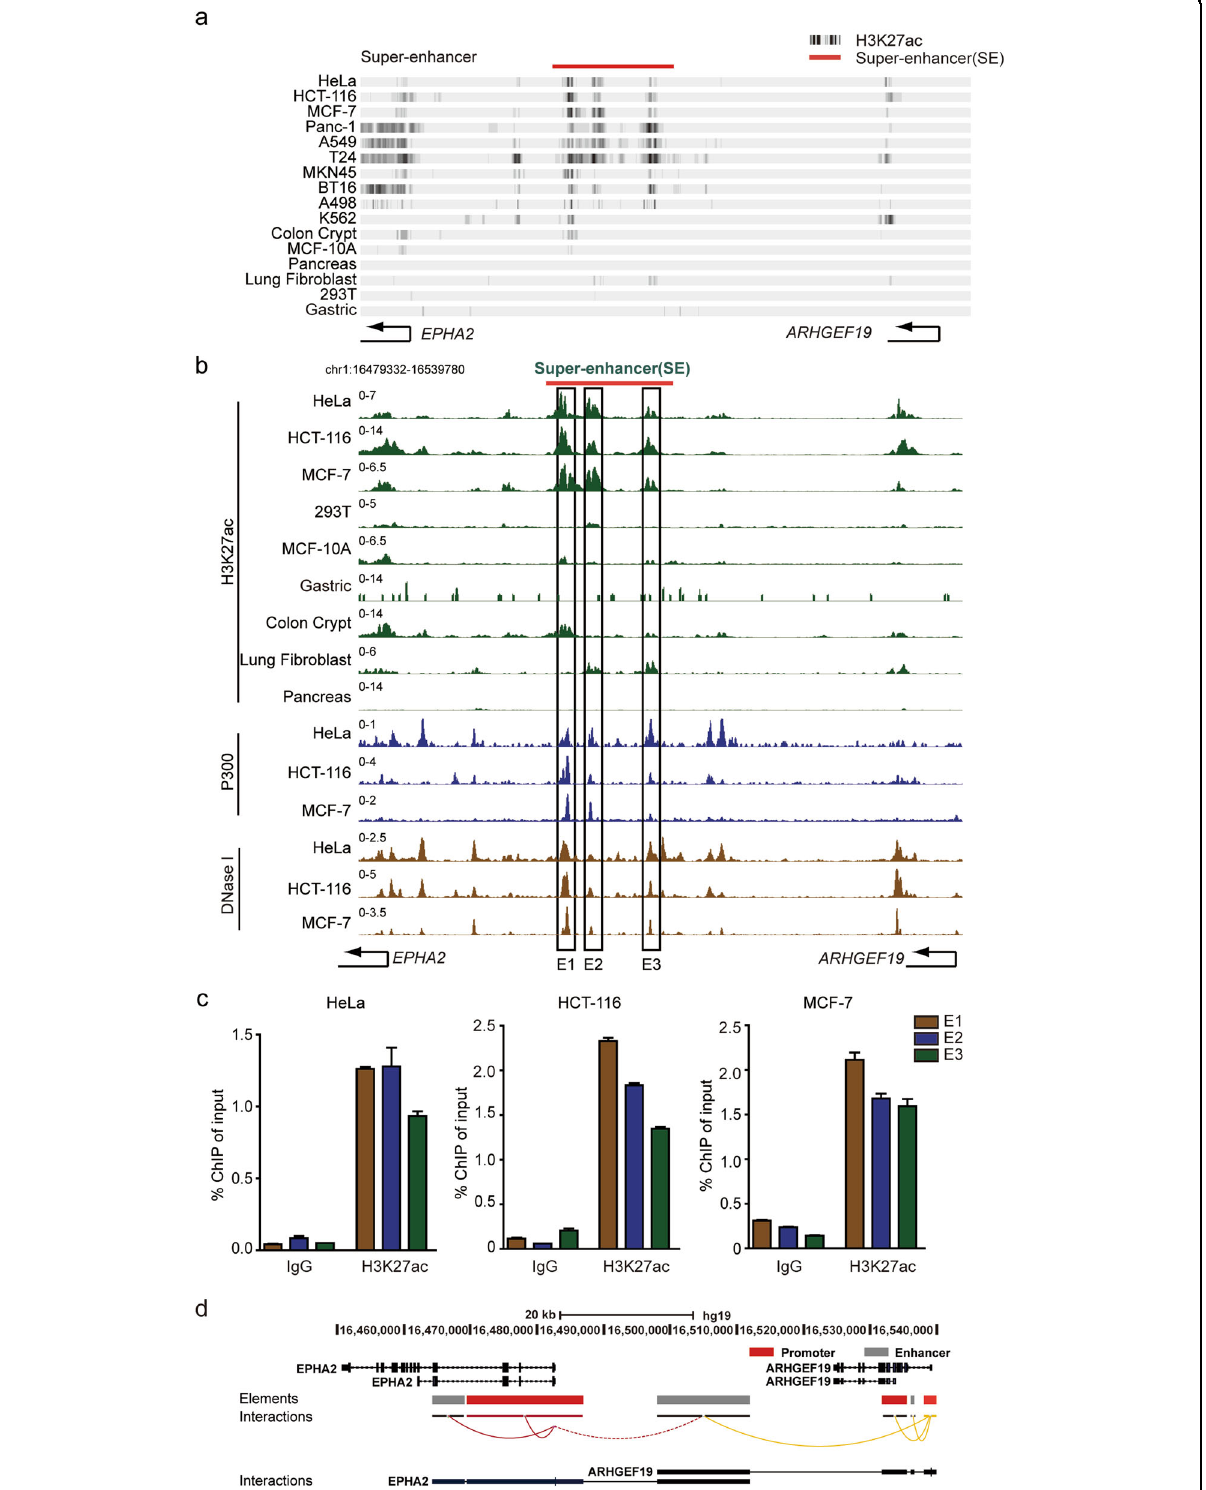
Fig. 1 Identi fi cation of a super-enhancer in ten tumor cells. a ChIP-seq binding pro fi les for H3K27ac enrichment were used to identify the super- enhancer in a variety of cancer cells. b The constituent enhancers of the super-enhancer (E1-E3) were identi fi ed based on markers of H3K27ac, P300, and DNase I in HeLa, HCT-116 and MCF-7 cells. c ChIP-qPCR analysis of H3K27ac in E1-E3 component enhancers in HeLa, HCT-116 and MCF-7 cells. d Promoters interacting with the super-enhancer were analyzed by GeneHancer